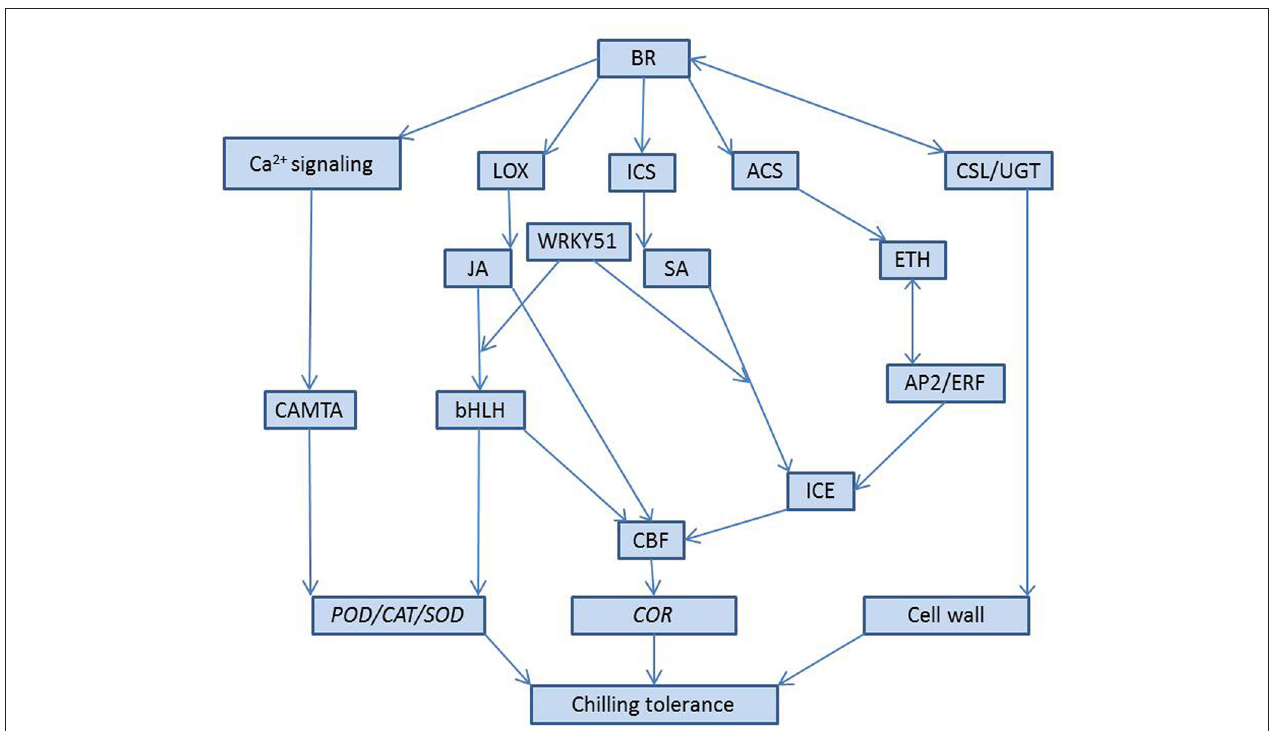
FIGURE 7 | Model depicting BR-mediated chilling tolerance via Ca 2 + , JA, SA, ETH signaling. LOX , ICS, and ACS are jasmonic acid biosynthesis gene, salicylic acid-related gene isochorismate synthase, and ethylene biosynthesis genes ACC synthase, respectively. WRKY51, bHLH, and AP2/ERF are all